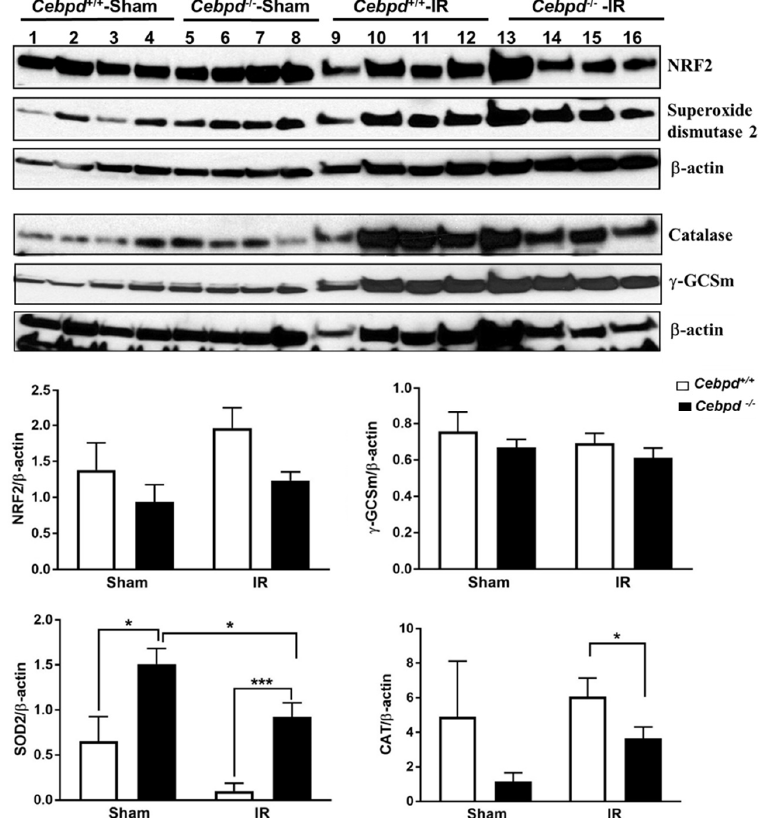
Figure 7. Expression of antioxidant response proteins in hippocampal extracts of sham and irradiated Cebpd +/+ and Cebpd − / − mice. Immunoblotting of hippocampal extracts probed for NRF2, SOD2, CAT, γ -GCSm and β -actin, n = 4 mice per genotype per treatment. * p < 0.05; *** p < 0.001.